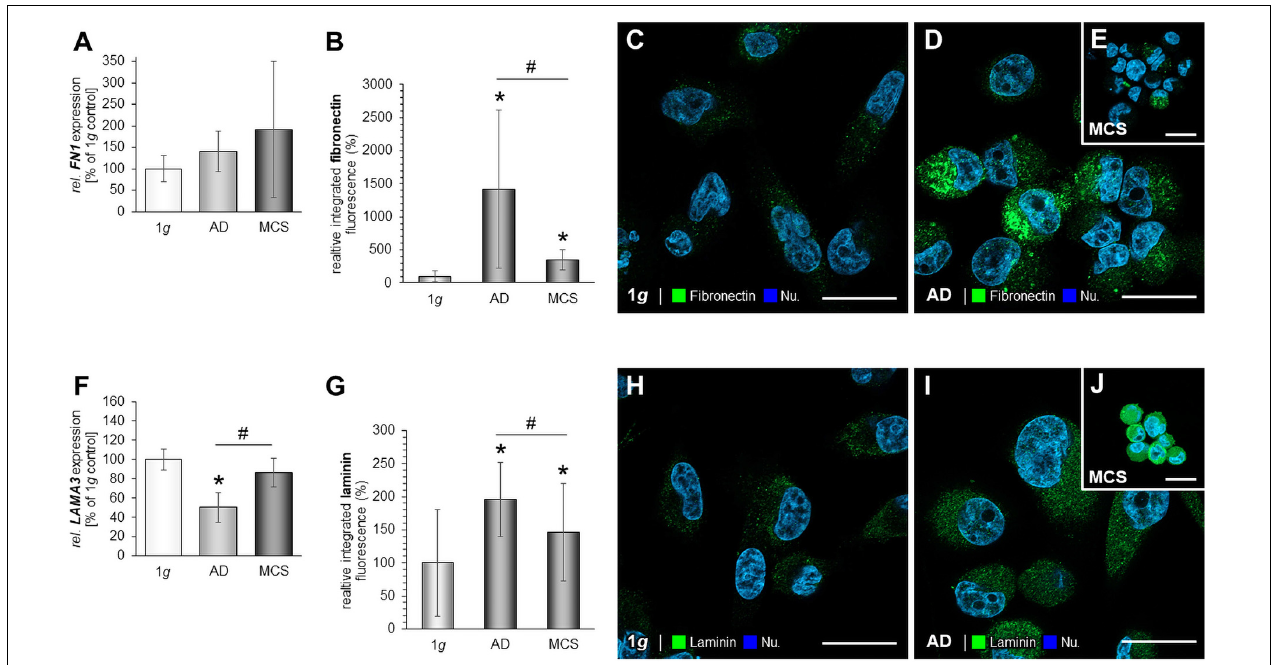
FIGURE 3 | Investigation of fibronectin (A–E) and laminin (F–J) : The gene expression of FN1 (A) , analysis of the fluorescence intensity of fibronectin (B) and immunofluorescence staining (IFS) of fibronectin in 1 g samples of MDA-MB-231 cells: (C) , RPM-AD samples (D) and MCS (E) ; the LAMA3 mRNA expression (F) as well as analysis of the fluorescence intensity of fibronectin (G) , the IFS of laminin in 1 g samples (H) , RPM-AD samples (I) and MCS (J) of MDA-MB-231 cells exposed to the RPM. * p < 0.05 1 g vs. AD and/or MCS and # p < 0.05 AD vs. MCS.